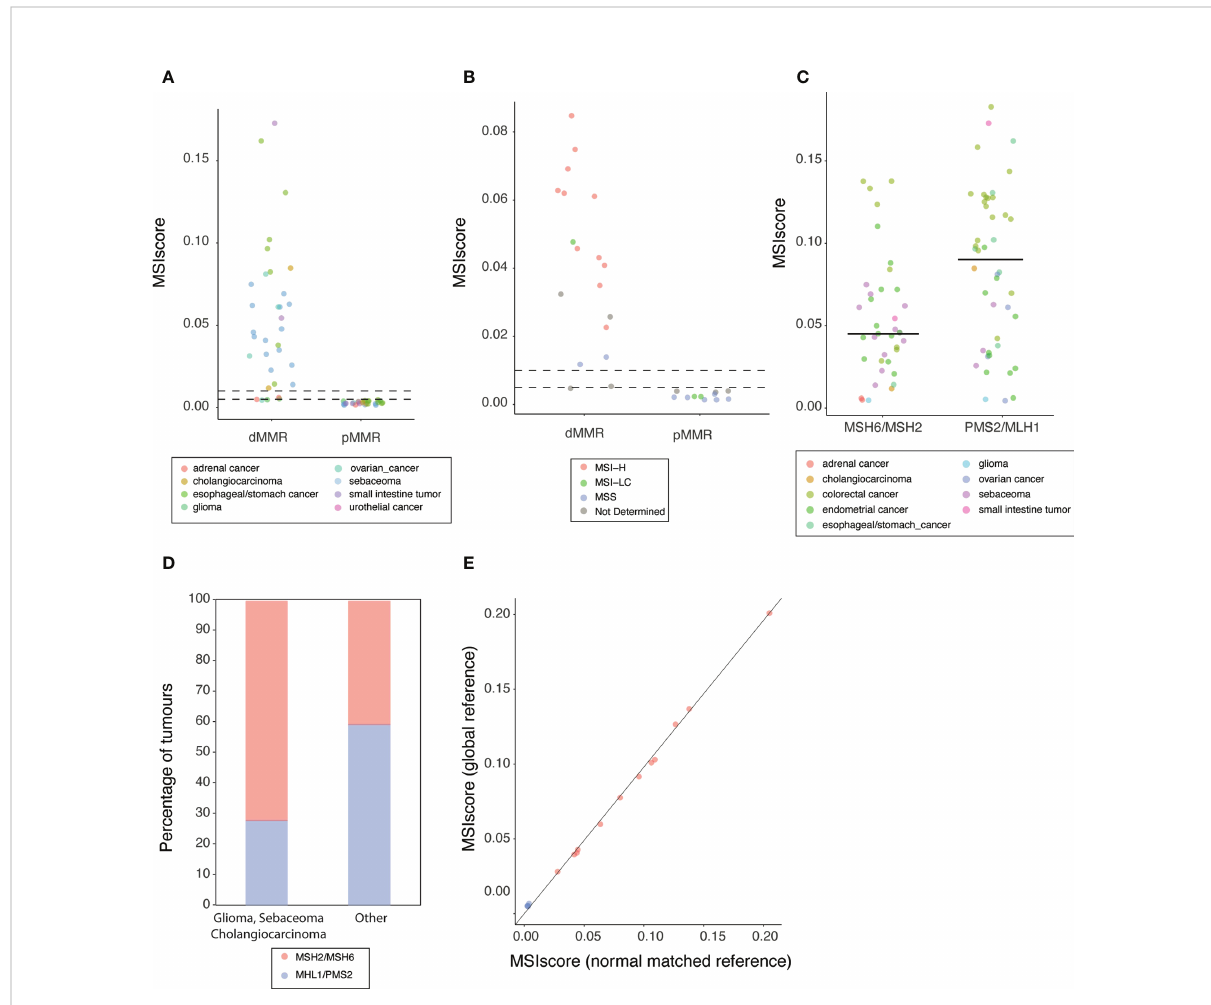
FIGURE 4 MSI detection in FFPE clinical samples (A) MSIscore obtained for dMMR or pMMR FFPE samples. Each point corresponds to one sample colored by tissue of origin (refer to legend in fi gure). Horizontal lines top to bottom indicates MSI-HC and MSI-LC threshold respectively (B) MSIscore obtained for glioma, sebaceoma and cholangiocarcinoma FFPE samples classi fi ed by IHC as dMMR or pMMR. Each point corresponds to one sample colored by MSI-PCR status. Horizontal lines top to bottom indicates MSI-H and MSI-LC threshold respectively. (C) MSIscore obtained for dMMR FFPE samples grouped by pairs of protein lost (x-axis) Each point corresponds to one sample colored by tissue of origin (refer to legend in fi gure). Horizontal lines indicate the median score for the group. (D) Histogram of the percentage of genes with detected loss of MSH2/MSH6 or MHL1/PSM2 grouped by cancer type (E) MSIscore obtained using either a global reference (y-axis) or a reference build using a matched- normal samples. Each point corresponds to one sample colored by MSI-PCR